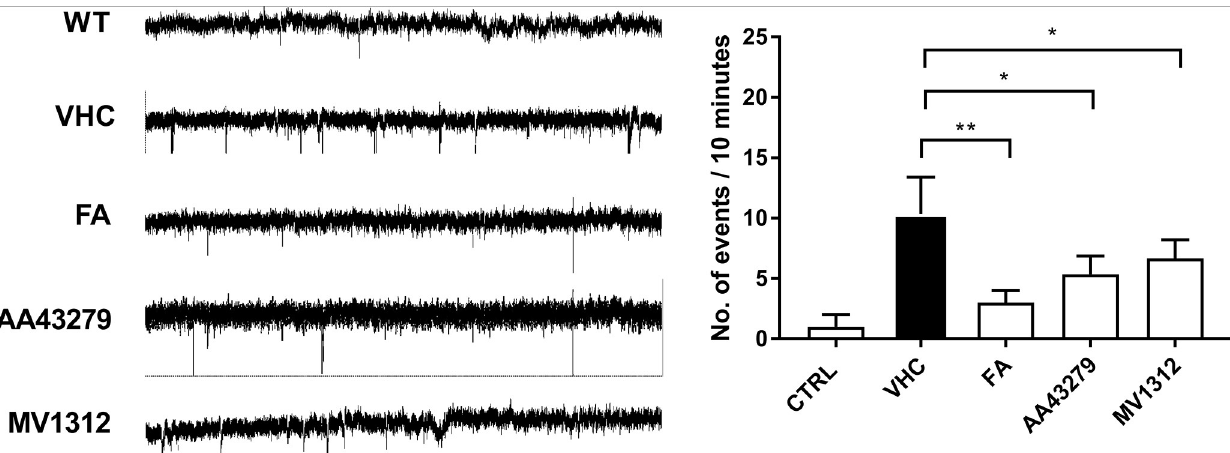
Fig 5. Epileptiform event scoring of wildtype or Scn1Lab knockout embryos exposed to FA, AA43279 or MV1312 for 60 minutes. Error bars = S.D n = 3 per group � < 0.05 �� < 0.005.